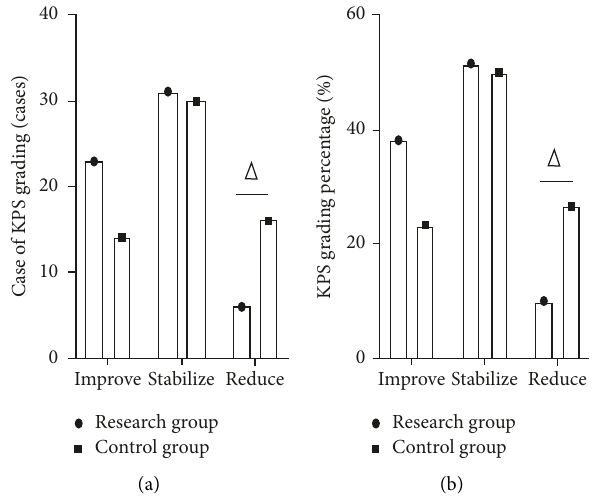
Figure 4: Comparison of KPS grading percentages for both groups. Note: Δ is the difference between the two groups, P < 0 . 05. (a) Case of KPS grading (cases) and (b) KPS grading percentage (%).